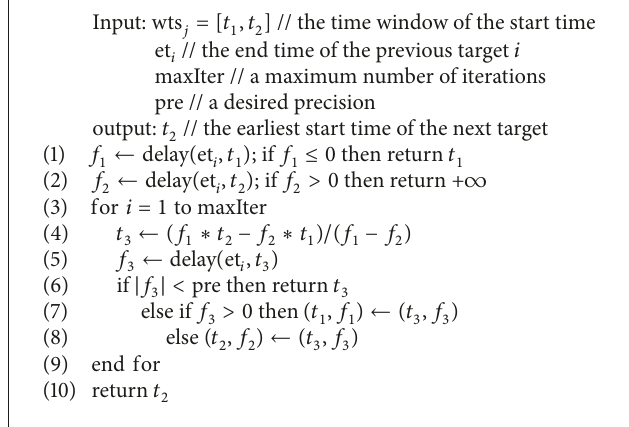
Algorithm 1: Iterative interpolation